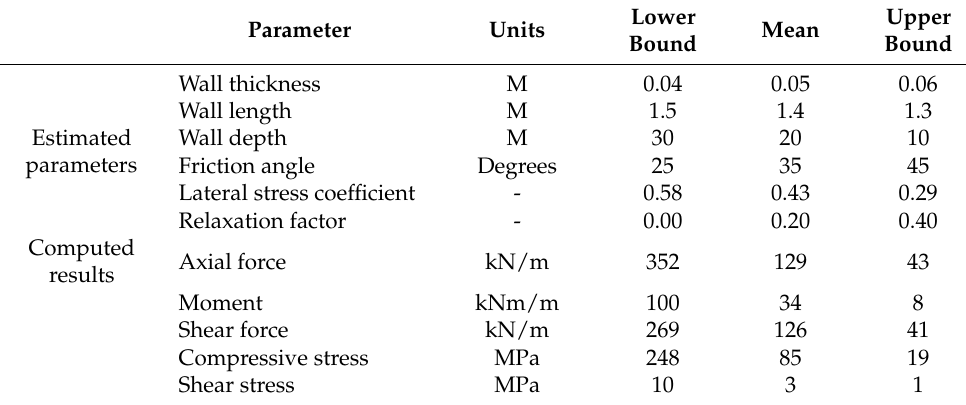
Table 2. Estimated parameters and computed results for tunnel wall